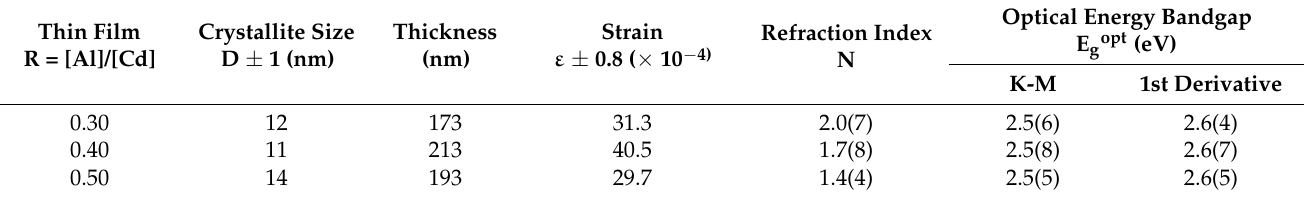
Table 1. Crystallite size, thickness, strain, refraction index, and energy gap values of the thin films.